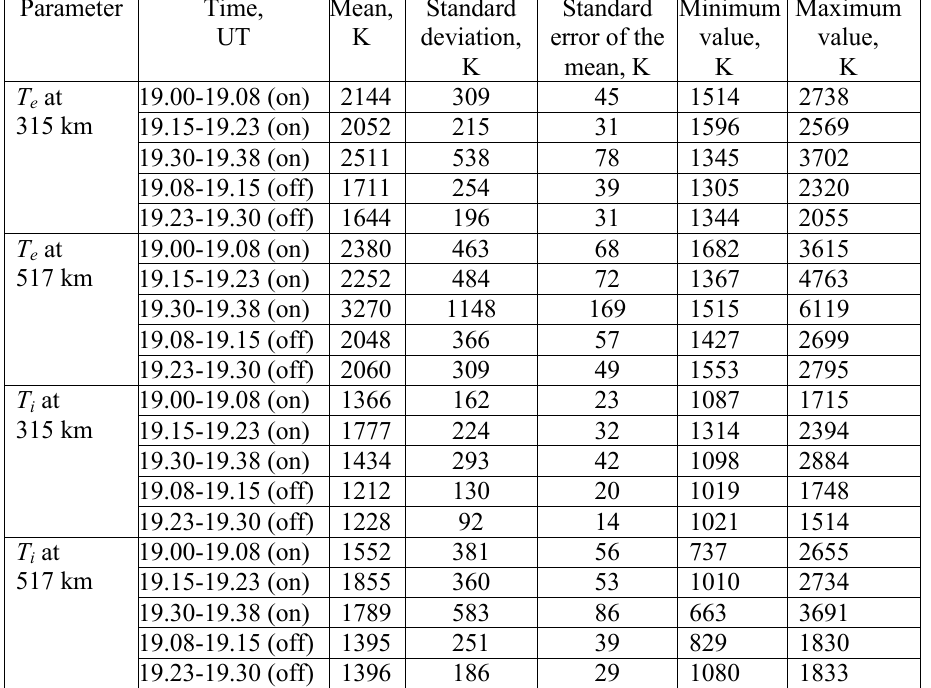
Table 2. The mean values, the standard deviations, the standard errors of the means, the minimum and maximum values of the T e and T i at altitudes of 315 and 517km calculated during the heater-on and heater-off periods on 2 October 1998. 500 km. Note that the EISCAT UHF radar was probing in the geomagnetic field-aligned direction. From Fig. 6 one